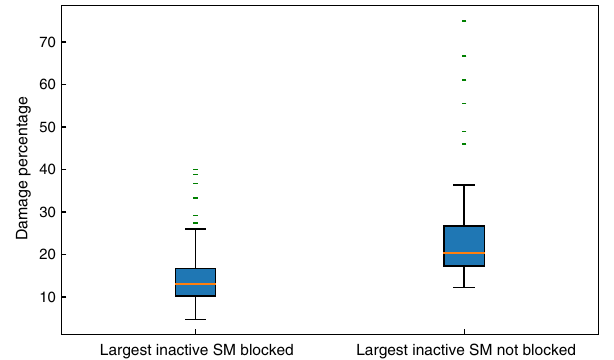
Figure 9. Box plots comparing the damage communities face if the largest inactive stable motif or motif group is completely blocked, i.e., all the drivers of this inactive stable motif or motif group are prevented from stabilizing versus if the same stable motif or motif group is allowed to stabilize. This analysis was performed over 100 randomly selected networks that contain 25 plant and 25 pollinator nodes. All the driver sets of an inactive stable motif or motif group are identified. From left to right the box and whiskers plots show the average damage percentage relative to the maximal richness community if the largest inactive stable motif is blocked and the same quantity if the largest stable motif or motif group is not blocked respectively. For the left box and whiskers plot, all combinations of inactive node states except the driver sets are considered, and for the right box and whiskers plot all combinations are explored. Due to the computational complexity caused by combinatorial explosion, this analysis was performed over 100 randomly selected 50-node